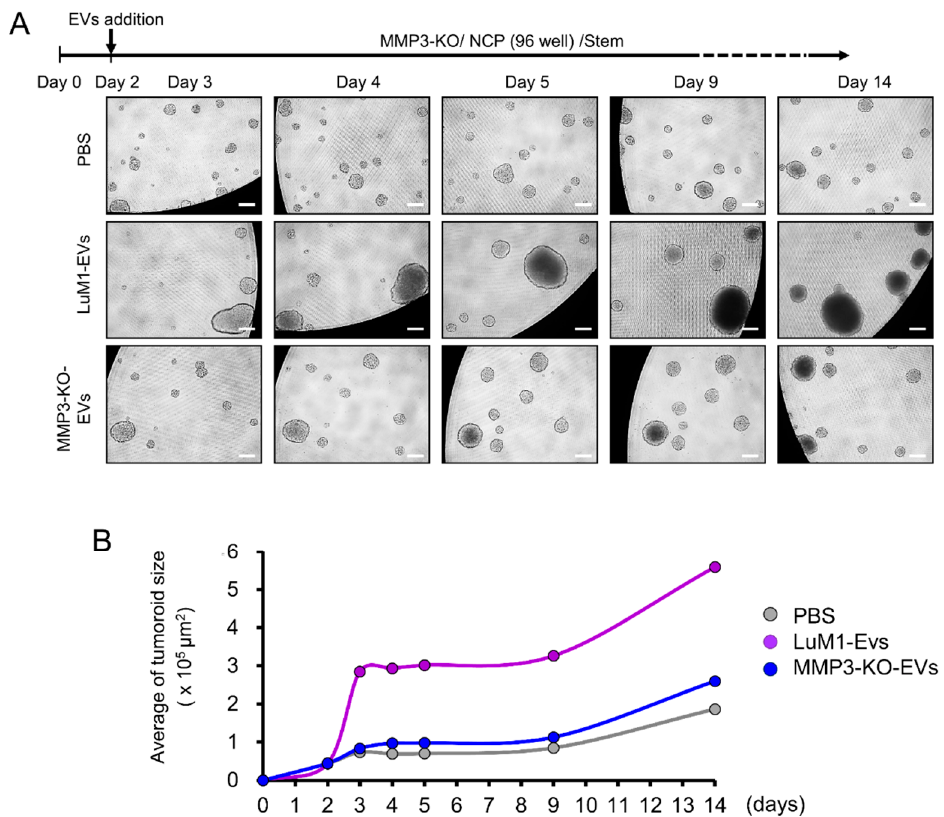
Figure 5. The addition of MMP3-rich EVs accelerated the in vitro tumorigenesis of MMP3-KO cells. MMP3-KO tumoroids were treated with PBS, LuM1-EVs, or MMP3-KO-EVs at a final concentration of 5 µ g / mL in the NCP-based 3D culture with the stemness-enhancing medium. ( A ) Experimental scheme (top) and representative photomicrographs (bottom) of tumoroid maturation at the indicated timepoints. Scale bar, 100 µ m. ( B ) A time plot graph showing the average size of the MMP3-KO tumoroids following the di ff erent treatments over the indicated time points. See the next figure for statistical analysis.